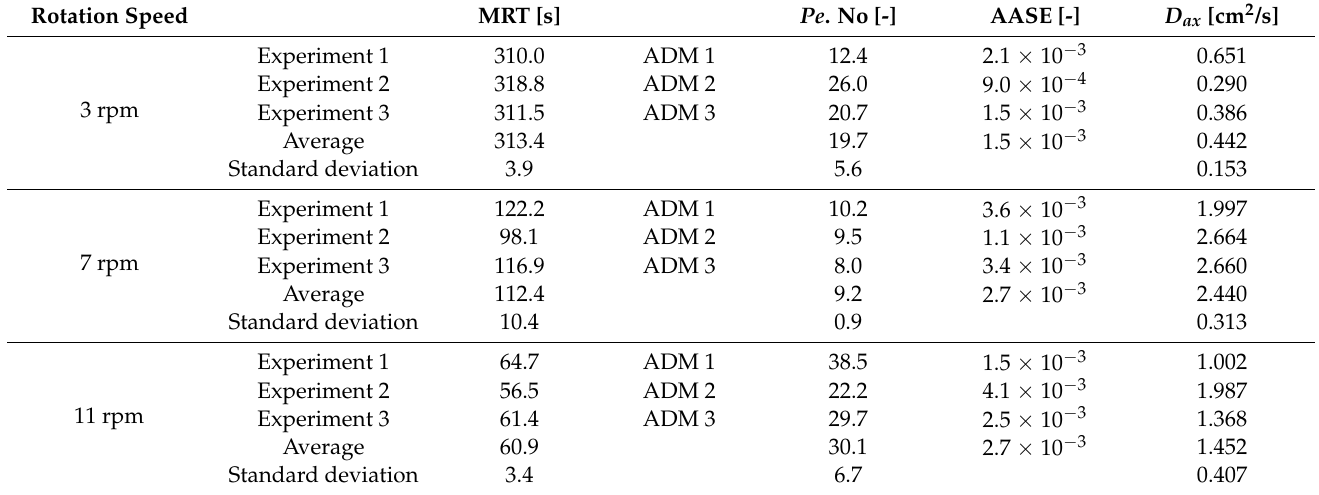
Table 2. Results of experiment and ADM at 3 ◦ and 1.08 cm 3 /s for 6 mm cubes. (Each experiment was repeated 3 times and ADM model was fitted on the three sets of